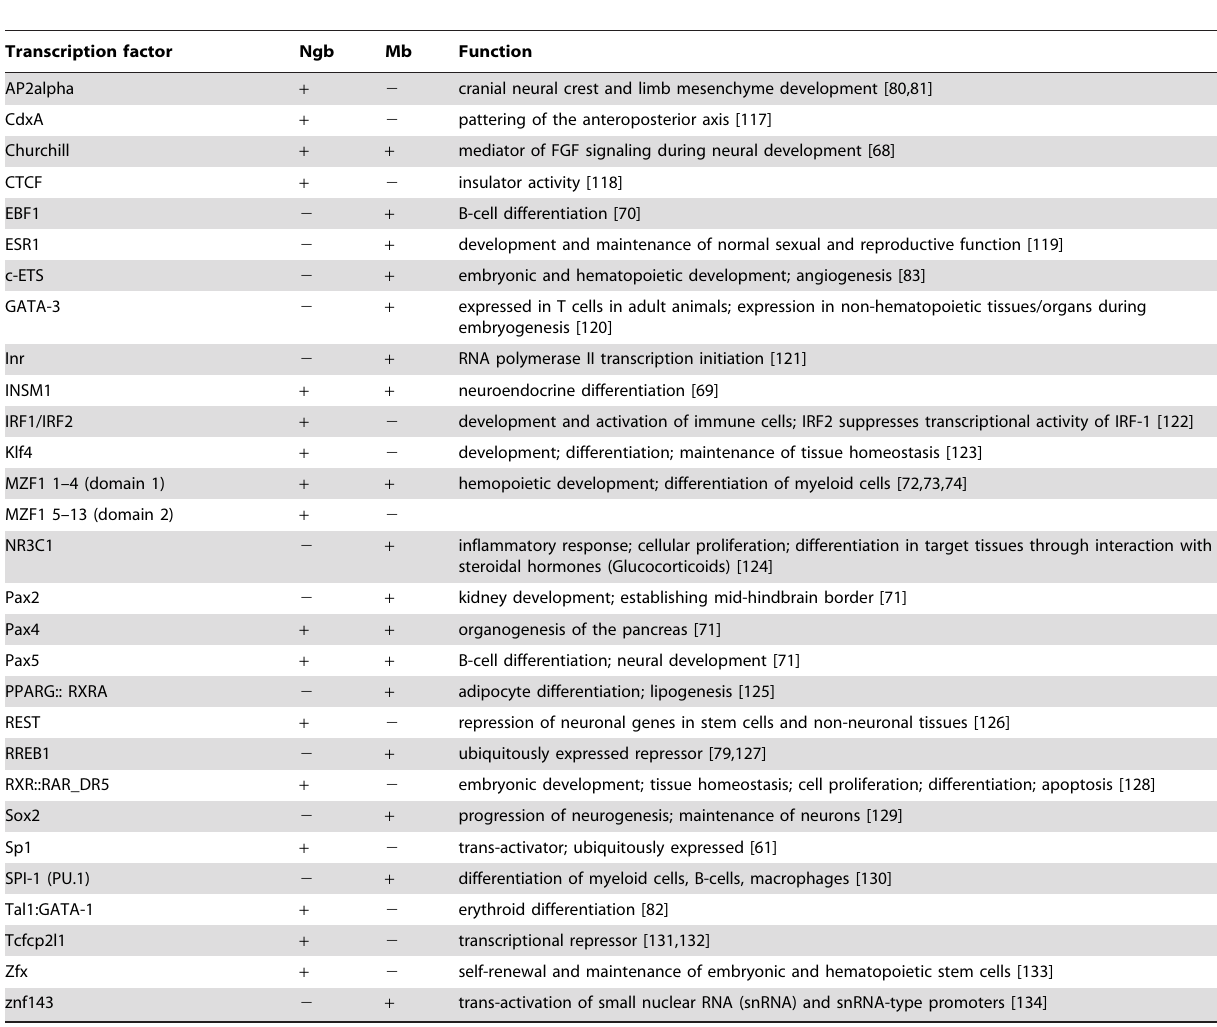
Table 1. Predicted motifs and possible corresponding transcription factors found via phylogenetic